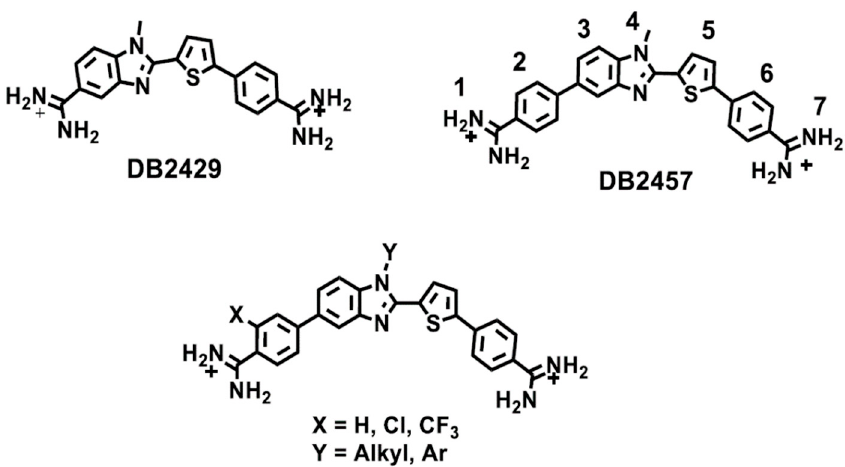
Figure 3. Structure of reported σ –hole single G · C bp binders and the modified compounds from DB2457.